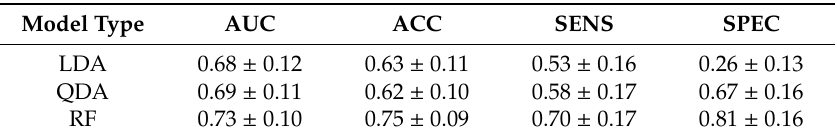
Table 4. The average AUC, accuracy (ACC), sensitivity (SENS), and specificity (SPEC) across 100 iterations for each classification scheme on D 1 using the 6 discriminating features from Experiment 1. These values were calculated using 3-fold cross validation. Each fold had an equal number of progressors ( n = 10) and non-progressors ( n =